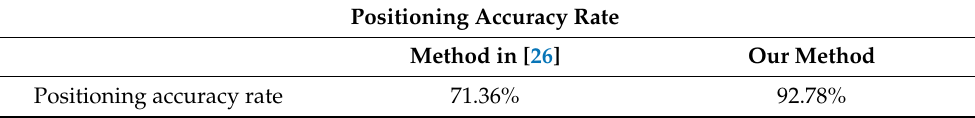
Table 3. Positioning accuracy